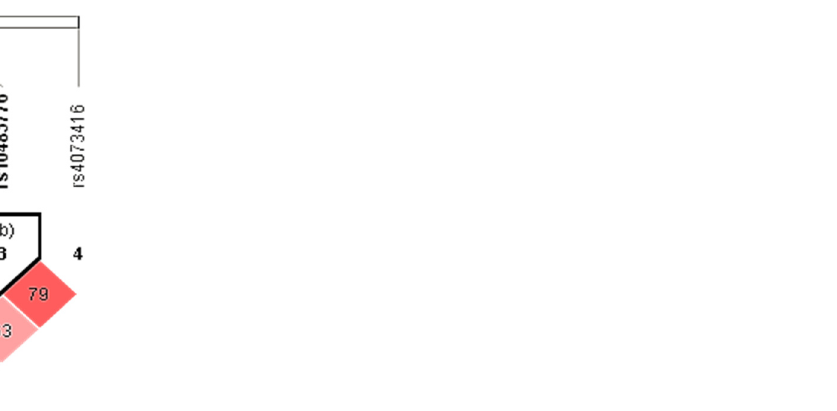
Figure 1. LD plot of the rs6573604, rs11621121, rs10483776, and rs4073416 polymorphisms located in the FUT8 gene-related region. Pairwise LD value (×100) for the rs11621121 and rs10483776 combination, as denoted in a bright red rectangle (D ′ = 93), indicates a strong link between these two polymorphisms.